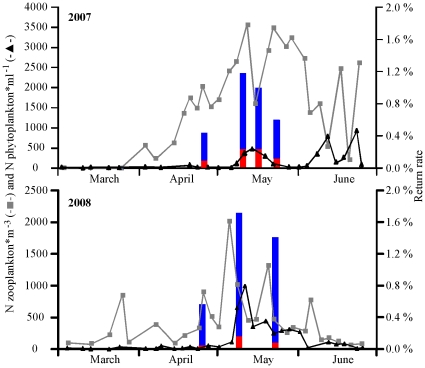
Zooplankton, phytoplankton, and return rates of coho salmon jacks (red bars) and adults (blue bars) released during 2007 and 2008.